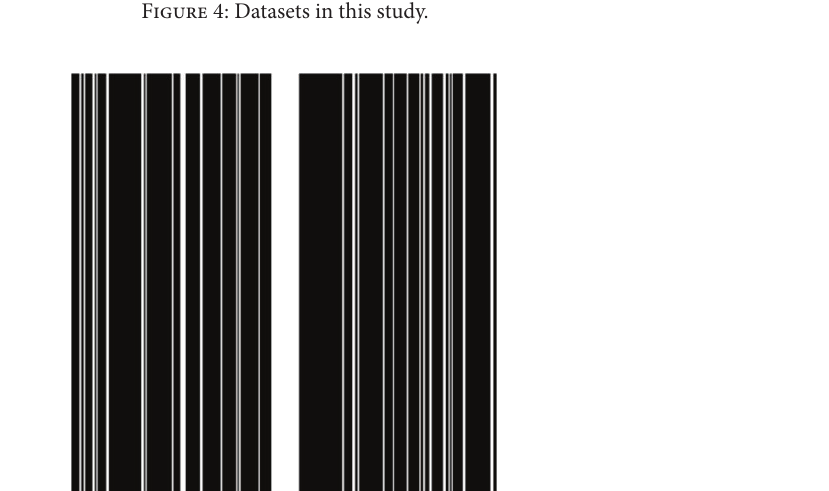
Figure 4: Datasets in this study.